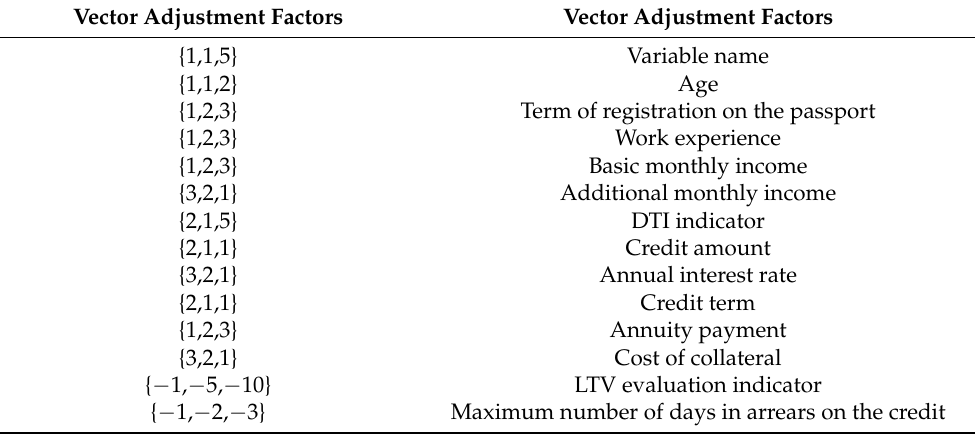
Table 1. Correction factor vectors for continuous numerical variables of the collector scoring model. Vector Adjustment